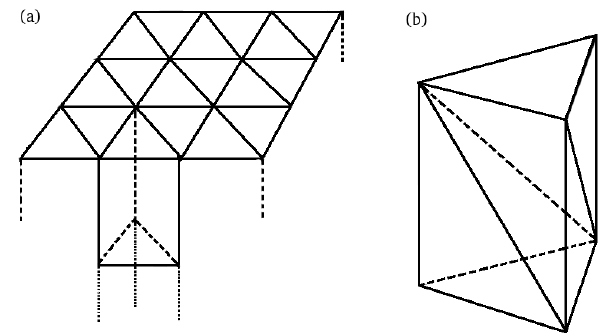
Fig. 2. Schematic of spatial discretization. The column under each Fig. 12. Schematic of spatial discretization. The column under each surface triangle is cut into prisms (a) , which can be divided into surface triangle is cut to prisms (a) , which can be divided to tetra- tetrahedra (b) . Except for layers adjacent to sloping ocean bottom hedra (b) . Except for layers adjacent to sloping ocean bottom each each prism is cut into three prism is cut to three tetrahedra.